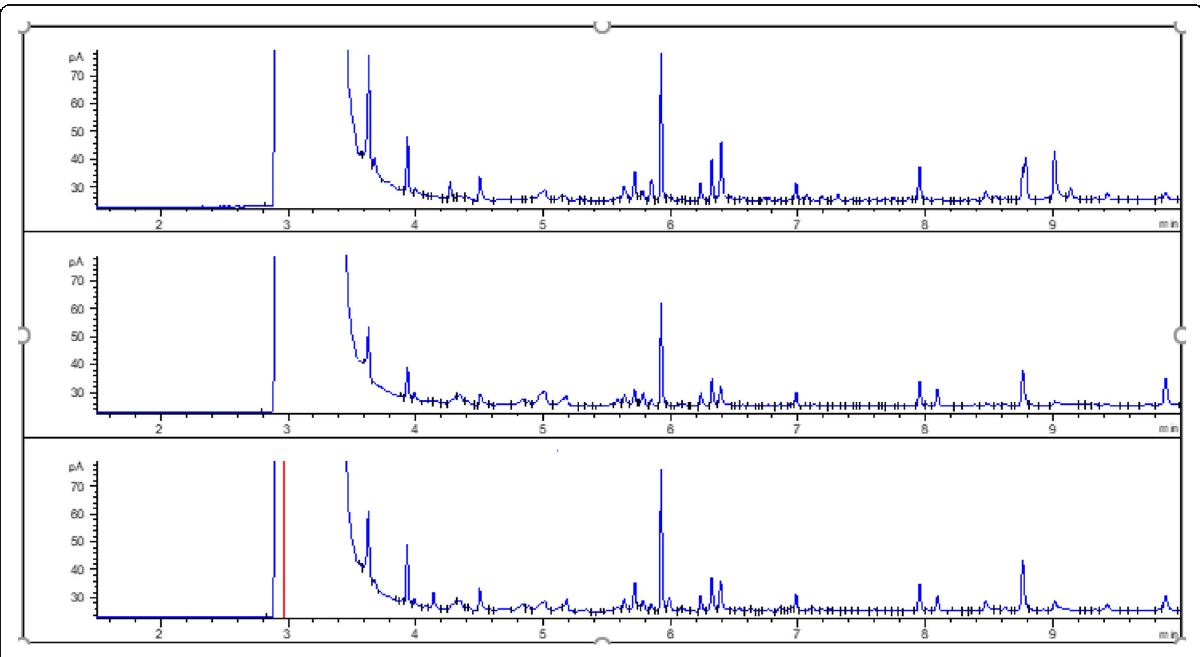
Fig. 4 Stacked chromatogram of shoes odour samples from three subjects